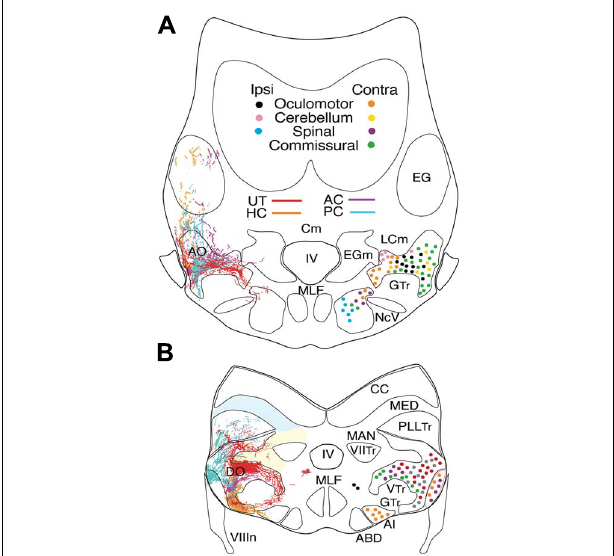
FIGURE 1 | Location of the octavolateral vestibular subdivisions within the goldfish hindbrain . A side view of the intact brain (A) and sagittal schematic diagram (B) are drawn at the same scale.Vertical dashed lines indicate rostro-caudal levels of the coronal sections shown in Figure 2 . AO, DO, MO, PO, anterior, descending medial, posterior octavolateral nuclei; CC, corpus cerebelli; Egr, external granule cell layer; FL, facial lobe; gr, corpus cerebelli granule cell layer; HYP, hypothalamus; III, IV, andVI oculomotor, trochlear, and abducens nuclei;VIIIn, IXn Xn, andVn, vestibular, glossopharyngeal, vagal, and trigeminal nerves; IO, inferior olive; LC, lobus caudalis; ML, molecular layer of crus cerebelli;VC, valvula cerebelli; OT, optic tectum; SC, spinal cord;T, tangential nucleus;VAG, vagal lobe.